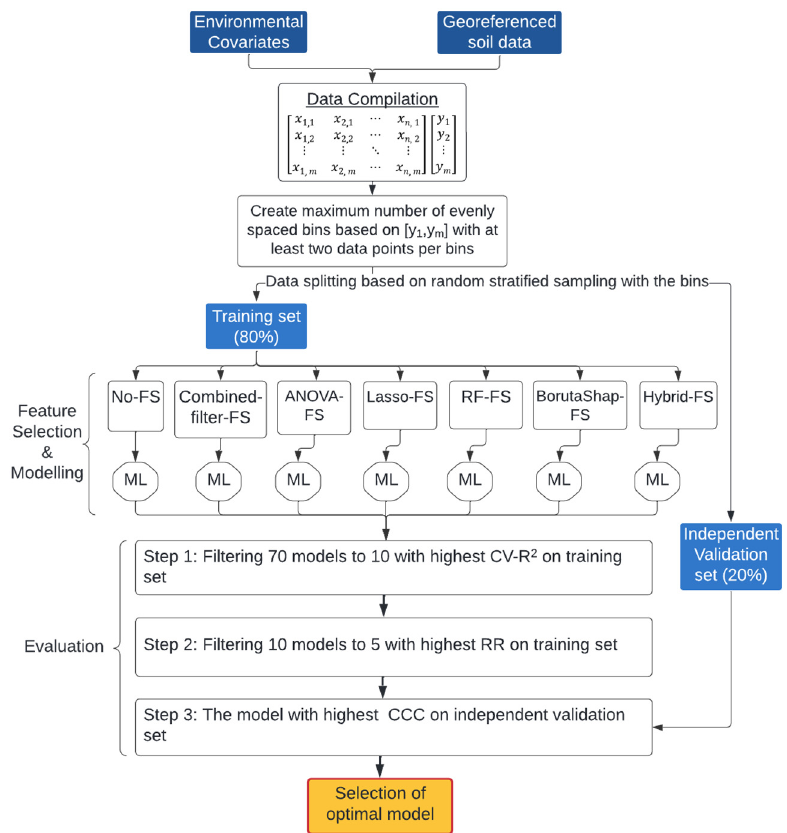
Figure 2. Evaluation process for selecting optimal models from the combinations of FS and ML algorithms tested. This process was applied to each sample set, which included five soil properties for ten individual fields and all fields combined.